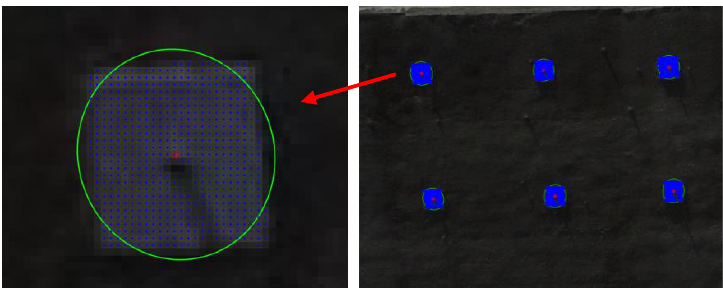
Figure 5. Metal plates on the nails, as extracted using the MSER algorithm. Further seen is the ellipse fitted to the pixels within the region and the centre of the ellipse as a highly stable point feature.